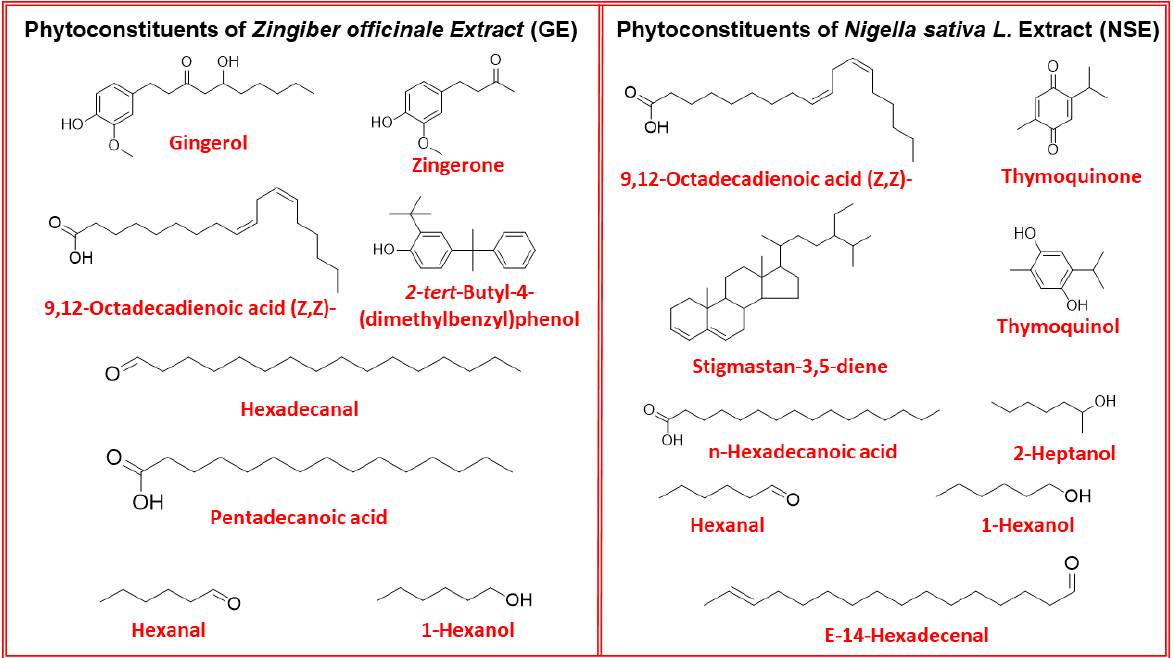
Figure 6. The presence of some of the different types of hydroxyl group containing phytochemical constituents of Z. officinale (GE) and N. sativa (NSE) extract. Table 1. Identified chemical compounds from N. sativa and Z. officinale .